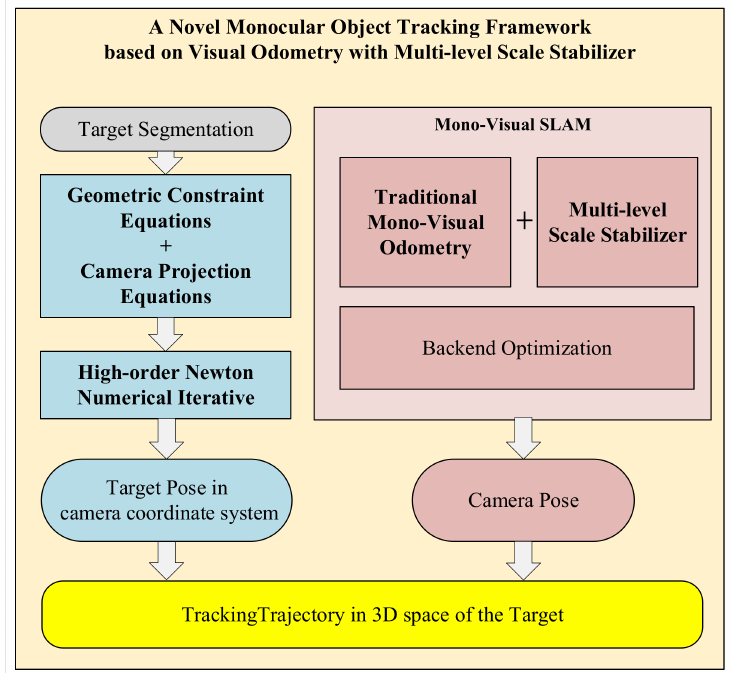
Figure 11. Target tracking framework of monocular motion platform based on multi-level scale stabilizer intended for visual odometry